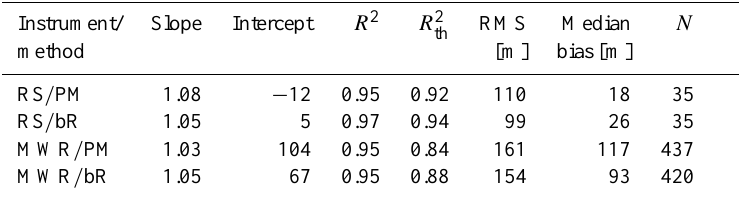
), root mean square error th